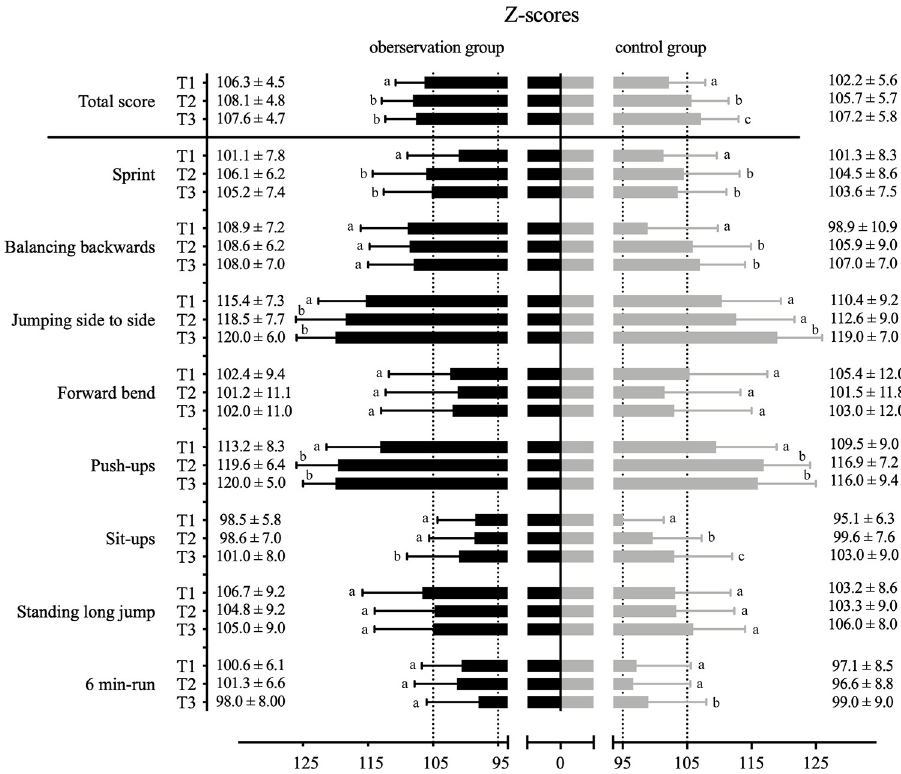
Fig 2. Z-scores of motor performance comparing observation and control groups at three time points. Data represents motor performance comparing means ± standard variations of OG and CG at three time points (T1-T3), calculated in Z-scores (total score) and in z-scores (individual exercises), normal range is marked by the dashed lines (N = 102–106). Letters refer to Bonferroni-corrected post hoc analysis of potential time effects, whereby different letters refer to significant differences between time points (P <